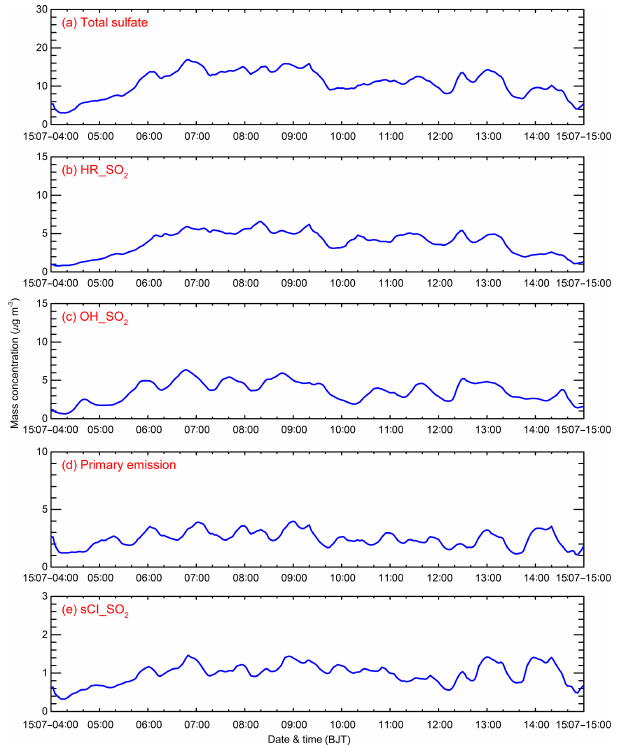
Figure 8. (a) Simulated diurnal profiles of the total sulfate mass concentration and contributions of (b) HR_SO2, (c) OH_SO2, (d) primary emissions, and (e) sCI_SO2 to the sulfate concentra- tion averaged over BTH from 4 to 15 July